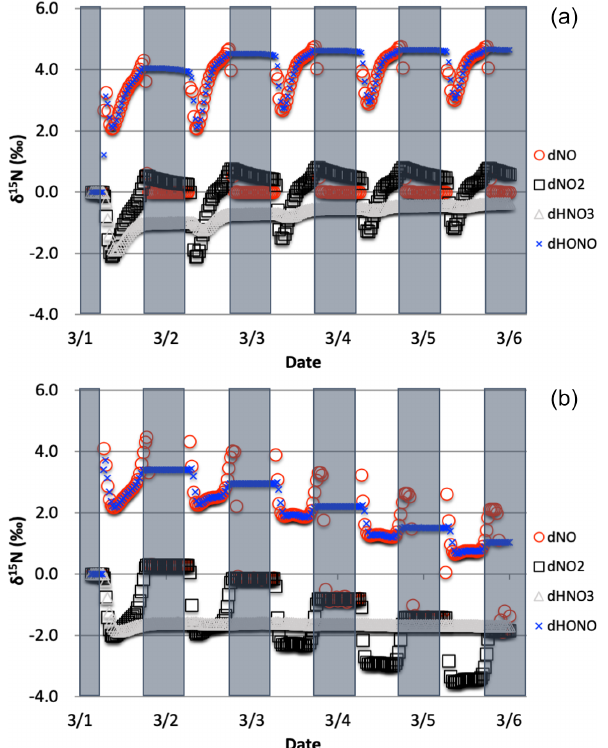
Figure 7. The δ 15 N values of NO, NO 2 , HONO, and HNO 3 with only the photolysis isotope fractionations active. The 5d simulation was under the conditions list in Table S3a–b. The gray boxes span night hours and the white span daytime. The top (a) is the simulation with NO x emissions and the bottom (b) is without NO x emissions.